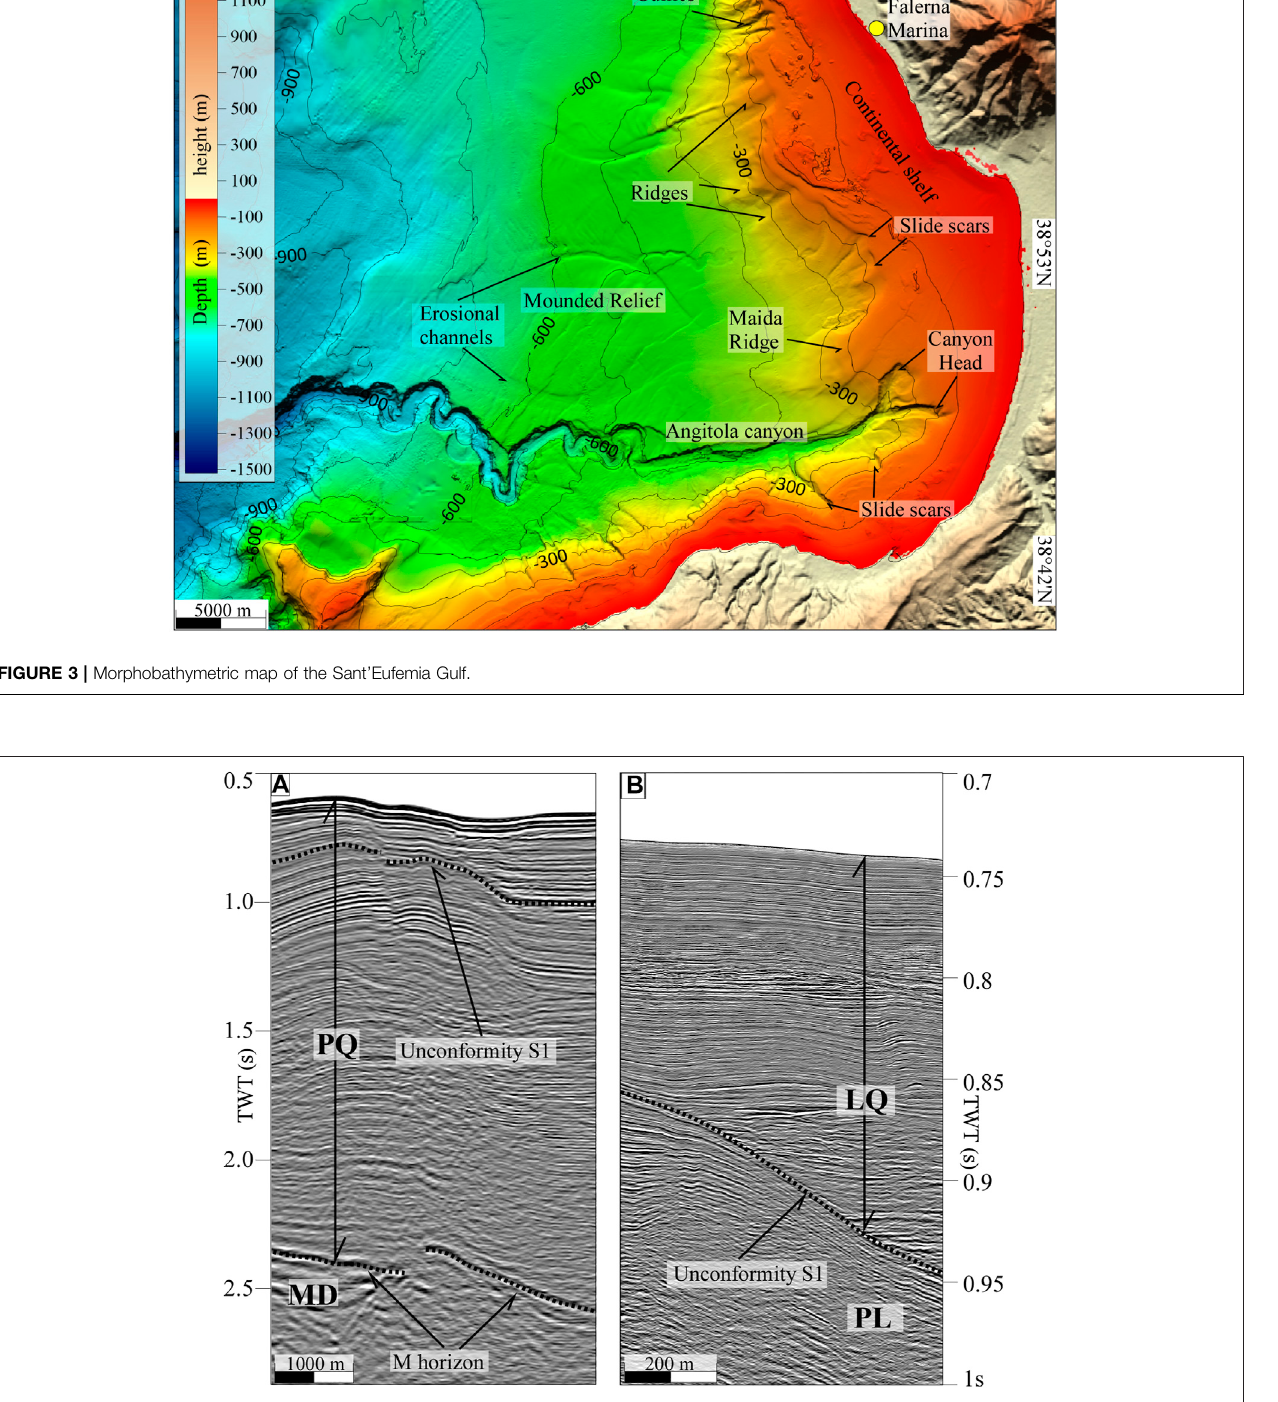
Frontiers in Earth Science |